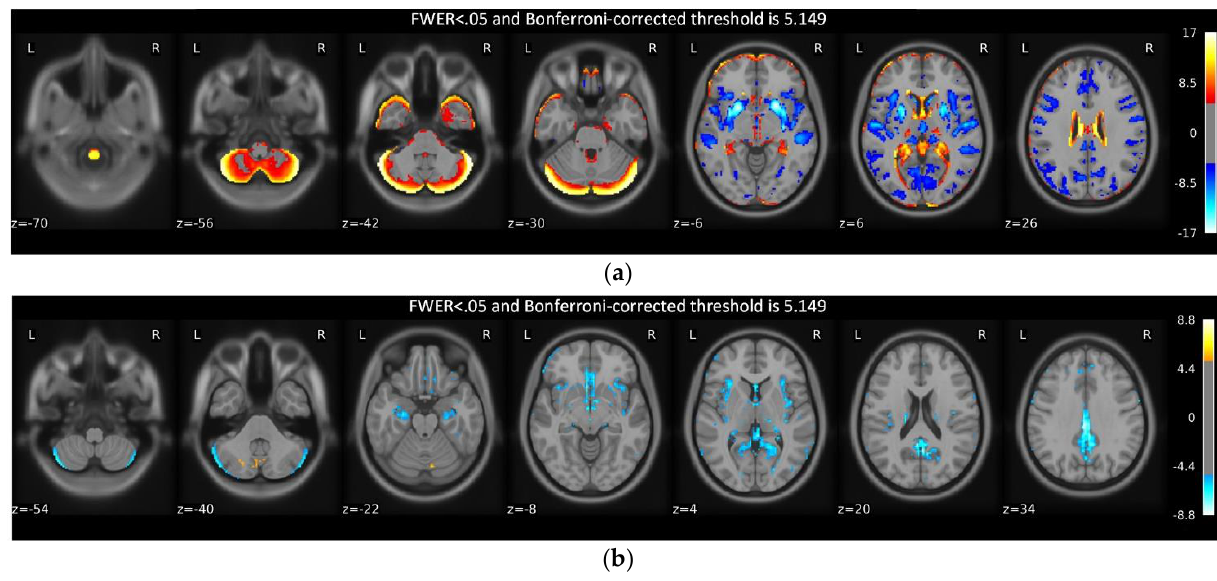
Figure 3. Statistical analysis results of GLM. The images are Bonferroni − thresholded z − statistic maps which show the statistical significance of effect size (weights of the linear model). The Bonferroni procedure was used to correct significance to reduce false positives, and the corrected threshold is 5.149 under FWER <0.05 (Family − Wise Error Rate). ( a ) Age effect on GMV; ( b ) Sex effect on GMV.